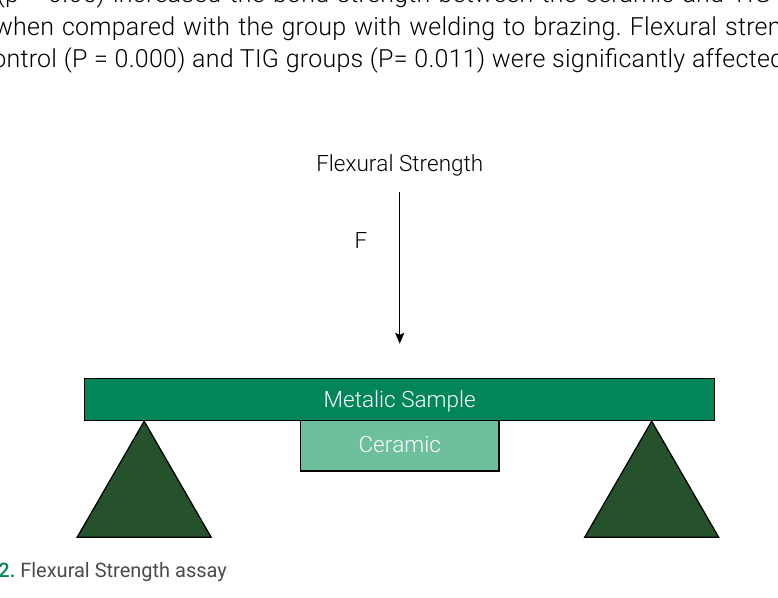
Figure 2. Flexural Strength assay